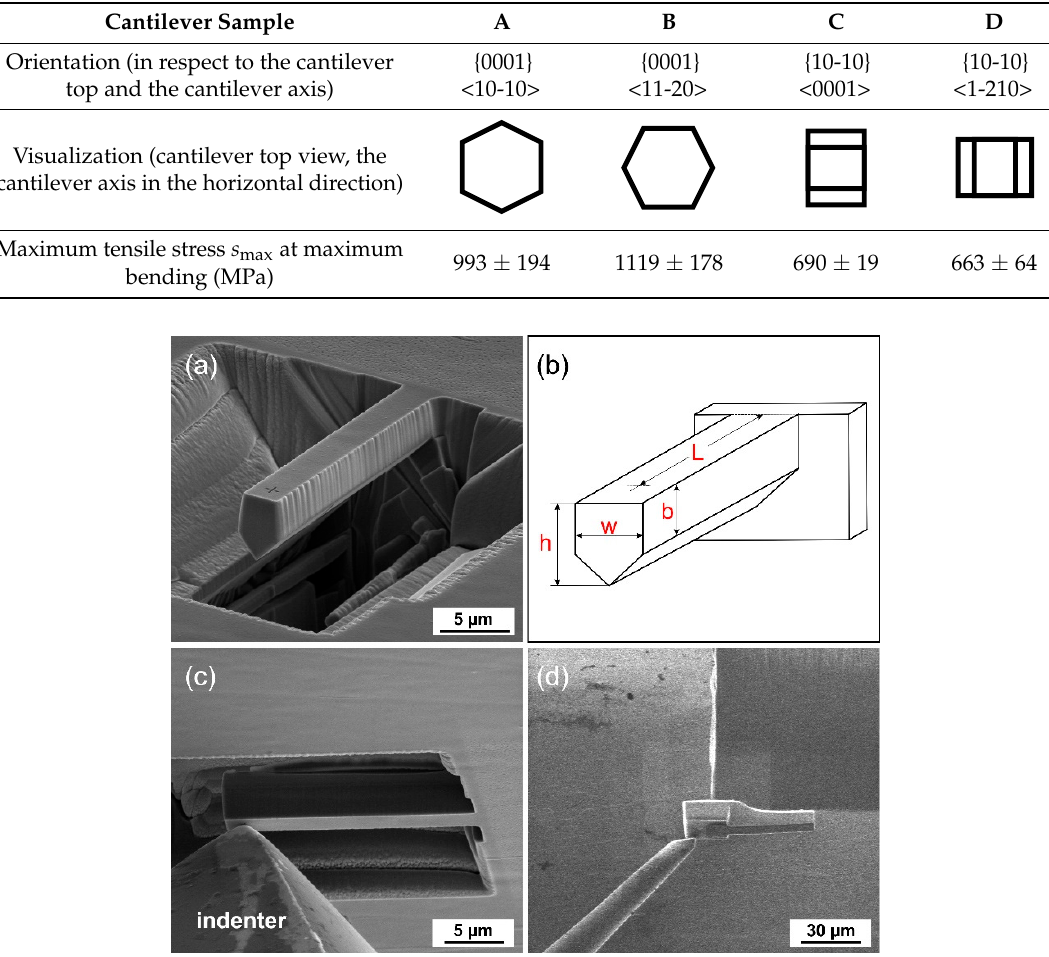
Figure 1. Microcantilever with pentagonal cross-section ( a ), schematic definition of geometric parameters ( b ) in situ microbending ( c ) and a cut-out of micro-cantilever ( d ). Table 2. Geometric parameters of representative samples A, B, C, and D (parameters L , w , b , and h are defined in Figure 1b).